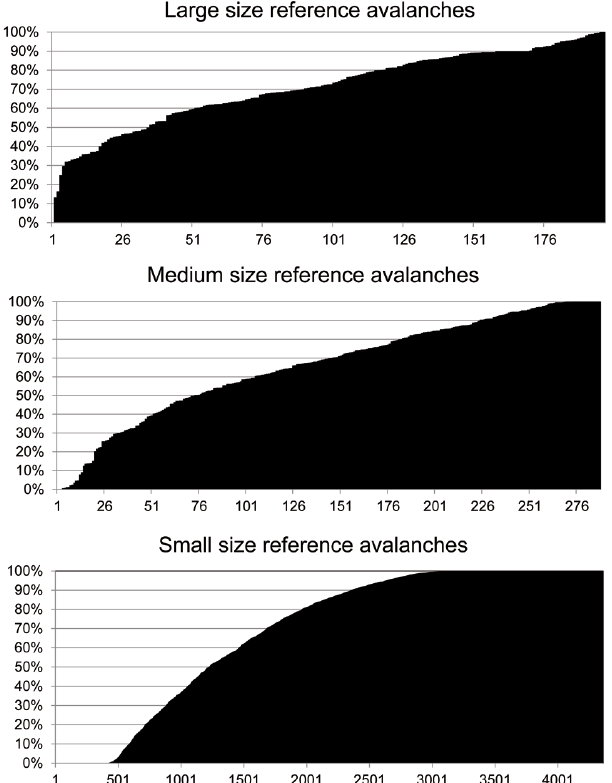
Fig. 9. Cumulative coverage of the reference release areas from the classes large ( > 100000m 2 ) medium (between 100000 and 50000m 2 ) and small ( < 50000m 2 ) by the result of the algorithm with 5m DEM resolution, a curvature threshold of 3 and a rugged- ness threshold of